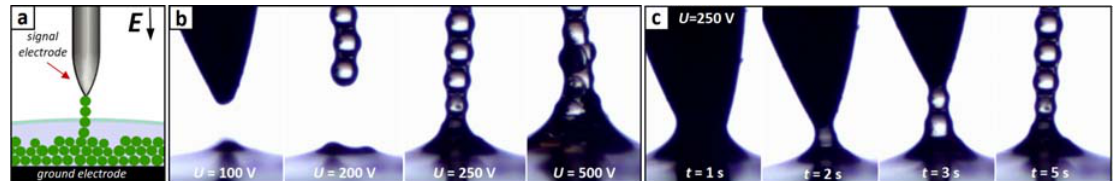
Figure 4. ( a ) A schematic representation of the fabrication process of particle chains; ( b )